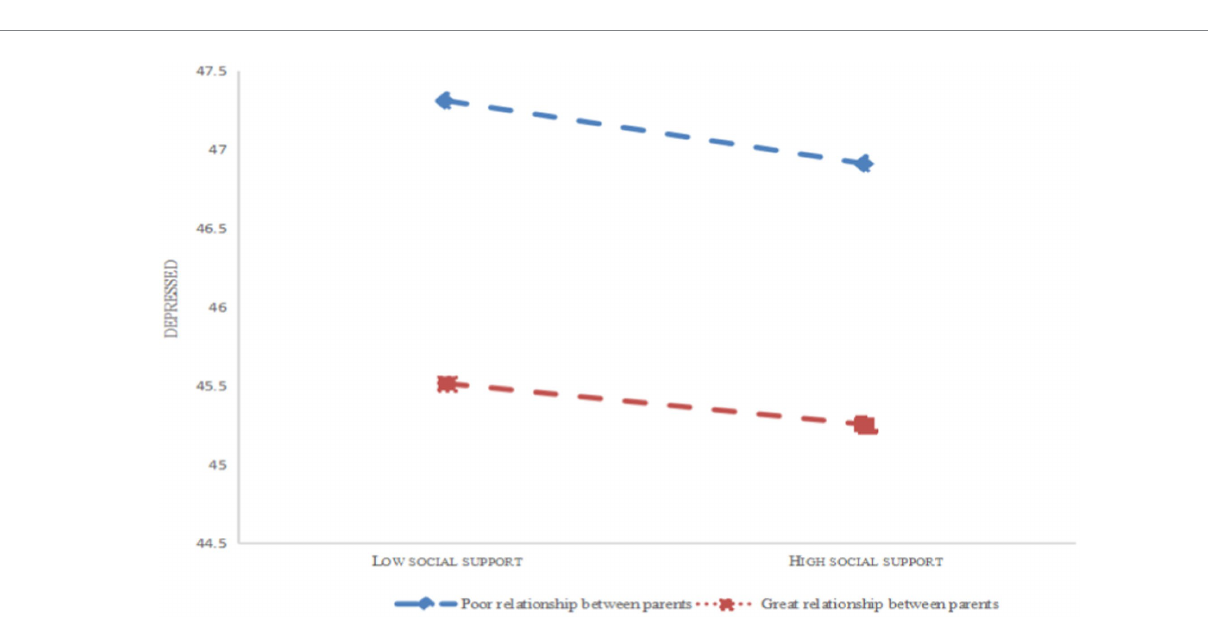
FIGURE 4 The moderating role of the parent–child relationship in social support and depression of college